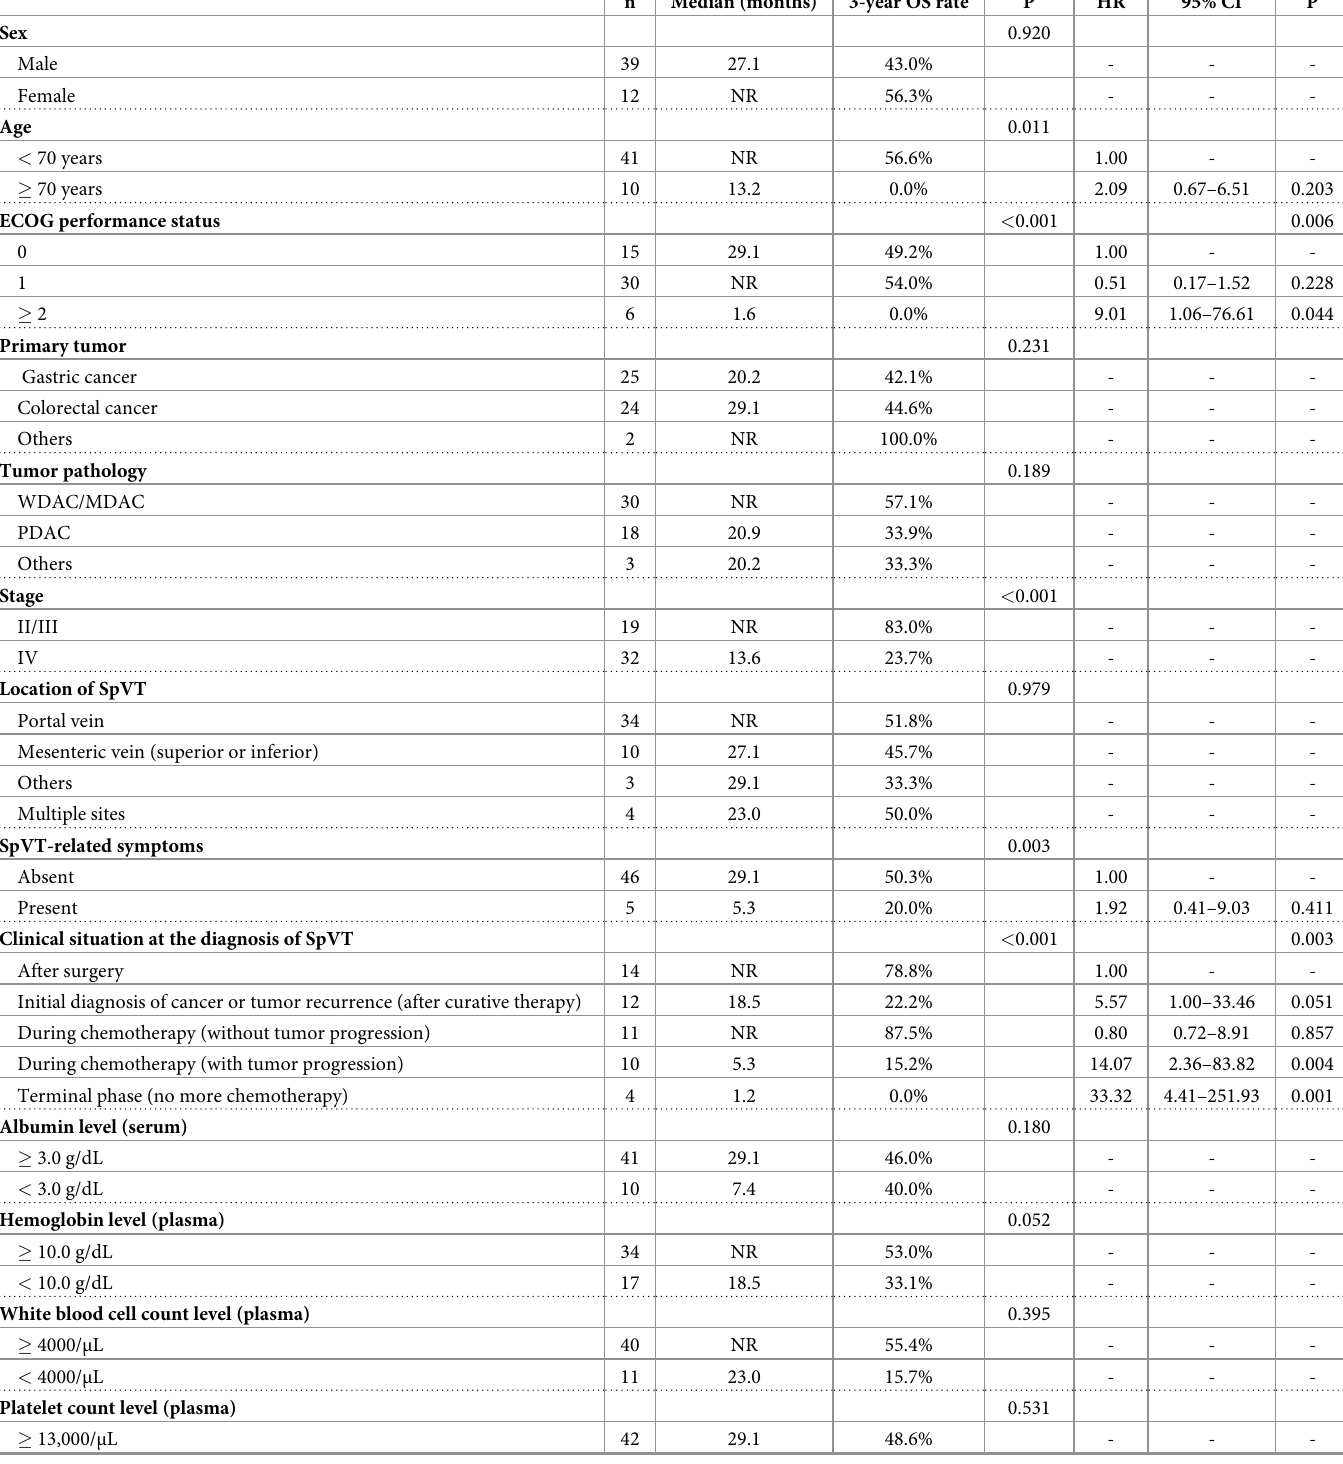
Table 3. Univariable and multivariable analyses on prognostic factors in patients with